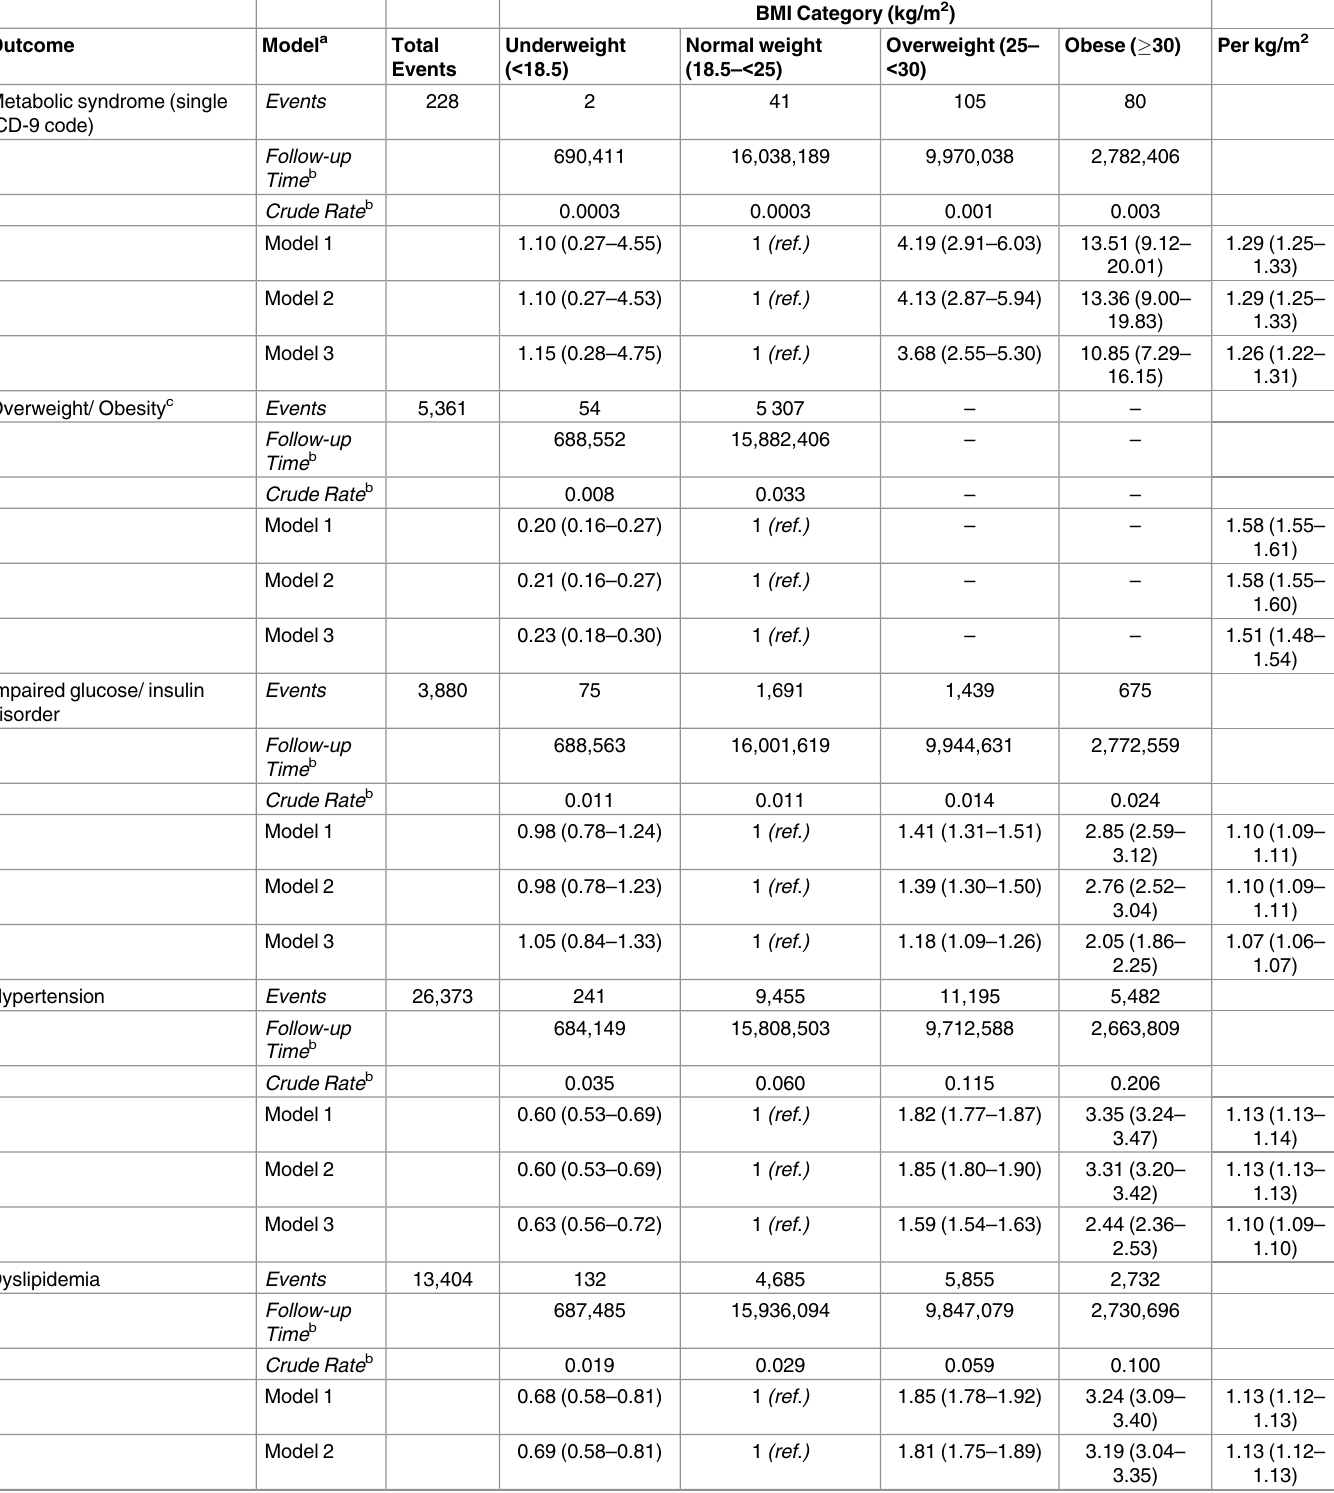
Table 2. Hazard ratios (95% confidence intervals) of broadly defined cardiometabolic risks across BMI categories at accession among 731,014US Army entrants,